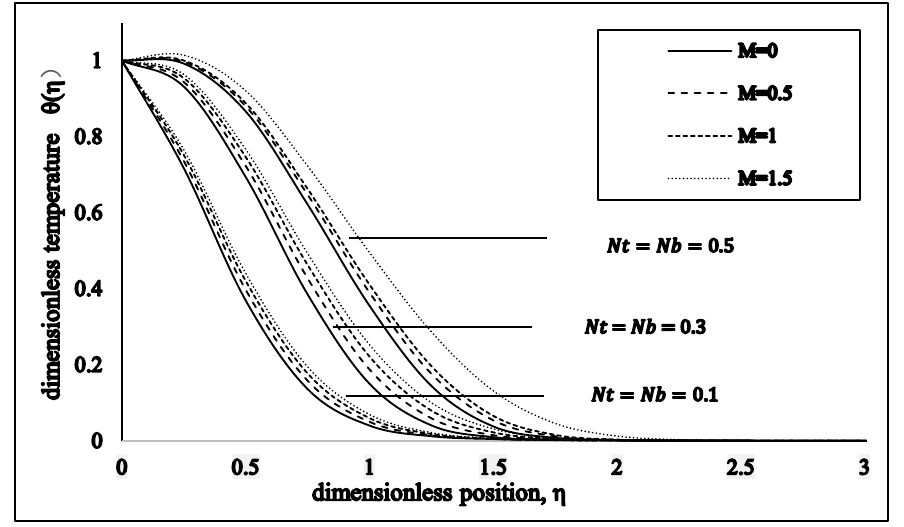
Figure 2. Impact of 𝑀, 𝑁𝑏 , and 𝑁𝑡 when 𝑃𝑟 = 𝐿𝑒 = 10 ,and 𝐸𝑐 = 0.1 on Temperature